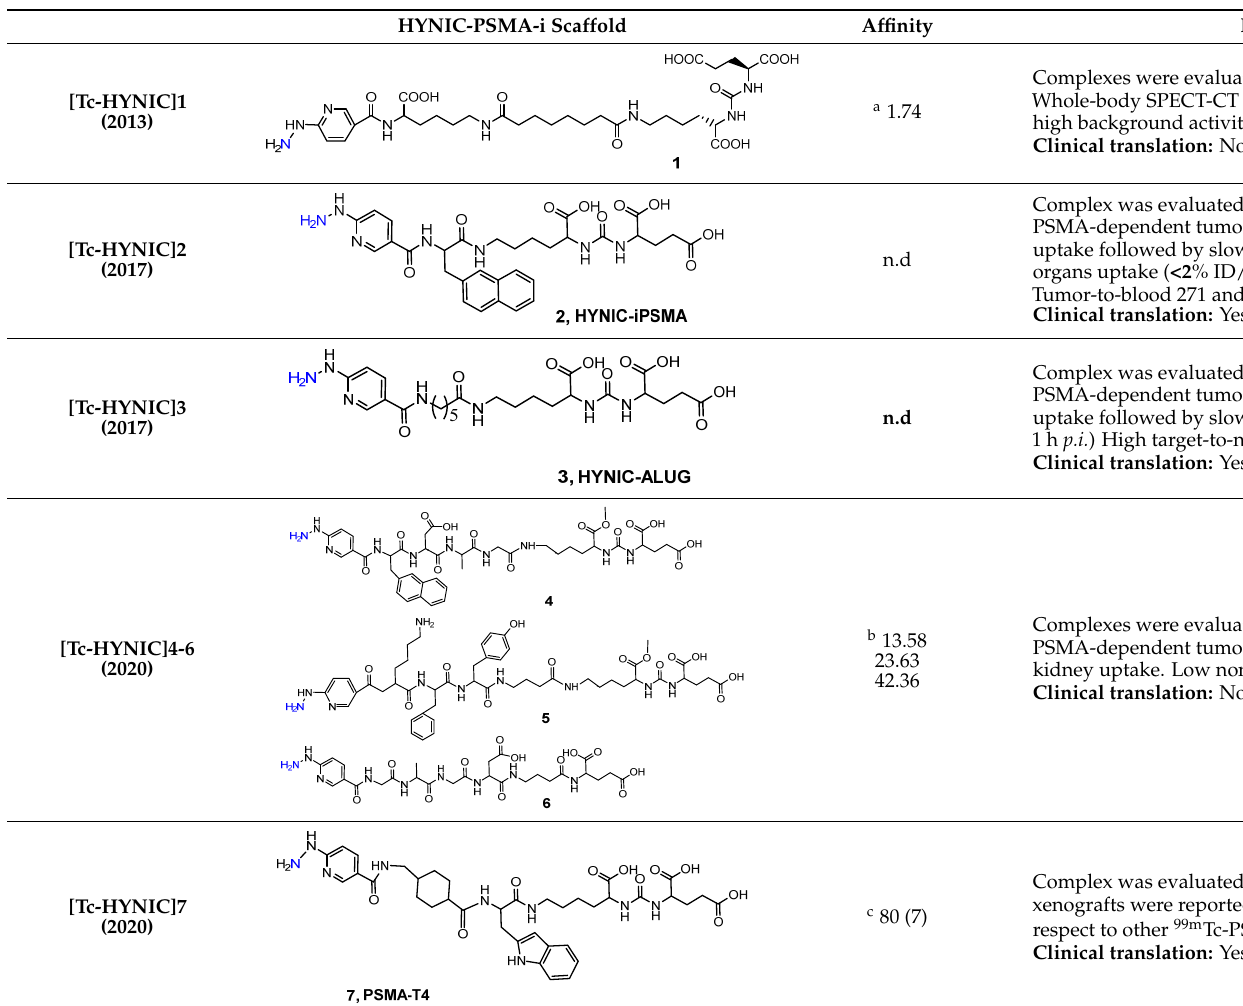
Table 6. PSMA-i labeled with [ 99m Tc][Tc-HYNIC] 2+ -core. HYNIC-PSMA-i Scaffold